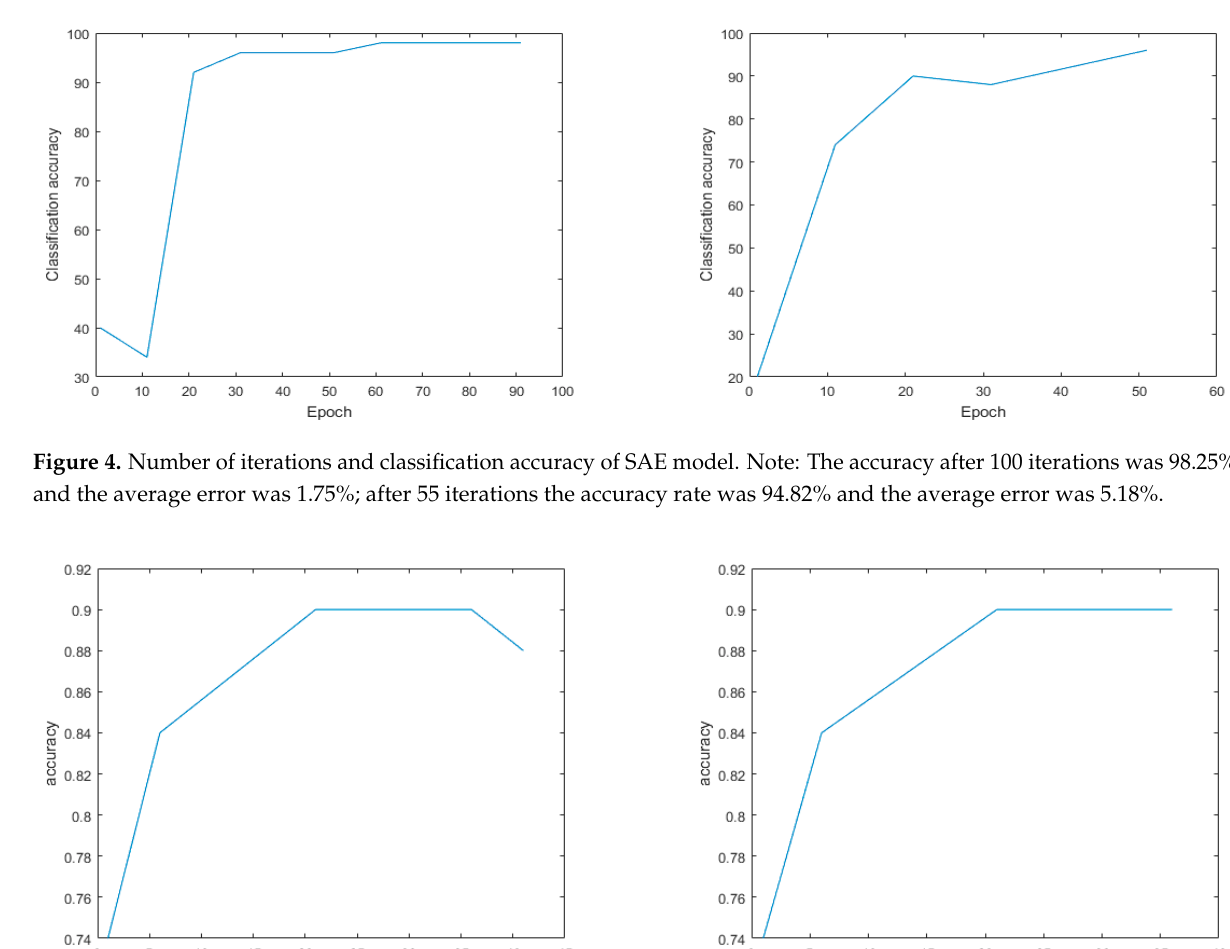
Figure 5. Number of iterations and classification accuracy of SVM model. Note: The accuracy of dimensionality reduction after 45 iterations was 88% and the average error was 22%; after 40 iterations, the accuracy rate was 90.00% and the average error was 10%.